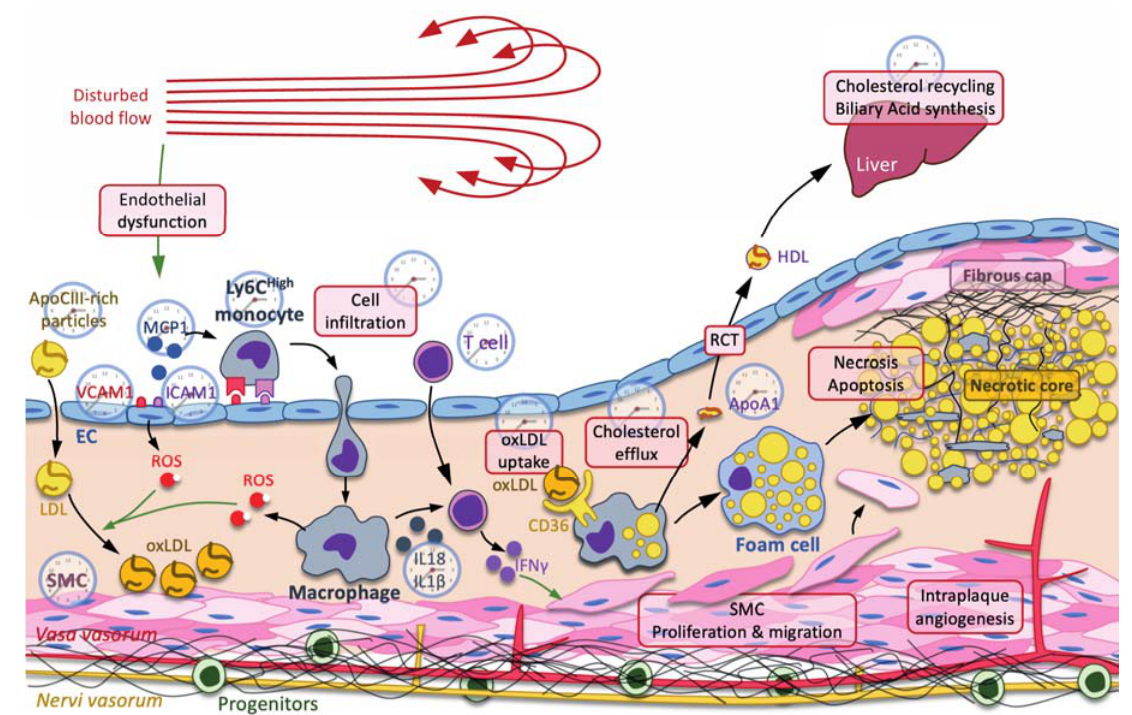
Figure 1. The clock and atherogenesis. Atherosclerosis is triggered by small dense low-density lipoproteins (LDL) and ApoC-III-rich remnant particles that accumulate in regions where the blow flow is disturbed. Low shear stress usually induces a mechanic stress, promoting endothelial dysfunction characterized by an increase in reactive oxygen species (ROS) production, secretion of cytokines, including monocyte chemoattractant protein 1 (MCP1), production of adhesion molecules, including vascular cell adhesion molecule 1 (VCAM1) and intercellular adhesion molecule 1 (ICAM1), and increased permeability to LDL and immune cells. Immune cells, such as neutrophils, monocyte-derived macrophages, T cells, etc., are then recruited to the subendothelial space. Infiltrated LDL are oxidized by reactive oxygen species (ROS) produced by endothelial cells (ECs) and macrophages. Oxidized LDL (oxLDL) are preferentially taken up by macrophages through the scavenger receptor CD36 for cholesterol recycling through the reverse cholesterol transport (RCT). In this pathway, ATP-binding cassette ABCA1 and ABCG1 mediate the efflux of cholesterol from the macrophage to ApoA1 and pre β -high-density lipoprotein (HDL). Cholesterol is transported back to the liver by HDL, where it is recycled in other lipoproteins or used as substrate in the biliary acid biosynthetic pathway. When RCT is insufficient and macrophages overwhelmed by massive cholesterol uptake, macrophages eventually become foam cells, where the accumulation of lipids leads to necrosis and apoptosis, thus forming the necrotic core. In addition to cholesterol metabolism, macrophages also produce cytokines, such as NLRP3 inflammasome-processed IL-18 and IL-1 β interleukins, which, together with IL-12, activate the T cell-dependent production of interferon (IFN) γ , among others. IFN γ stimulates the proliferation and the migration of smooth muscle cells (SMC) toward the necrotic core in order to stabilize it by secreting fibers, including collagen, thus forming the fibrous cap. Each process or molecule that is regulated by one or several clock components is represented by a clock. Green arrow: induction.